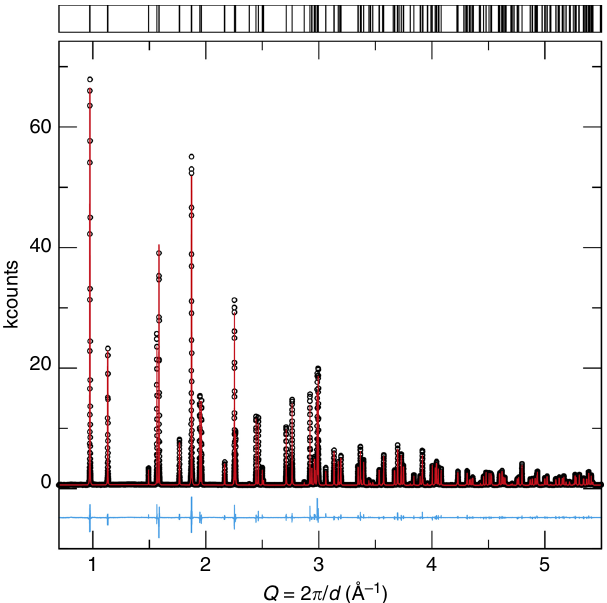
Fig. 4 Rietveld re fi nement of NaBaB 9 O 15 synchrotron X-ray powder diffraction data. The observed data are colored black, the re fi nement is colored red, and the difference is colored blue